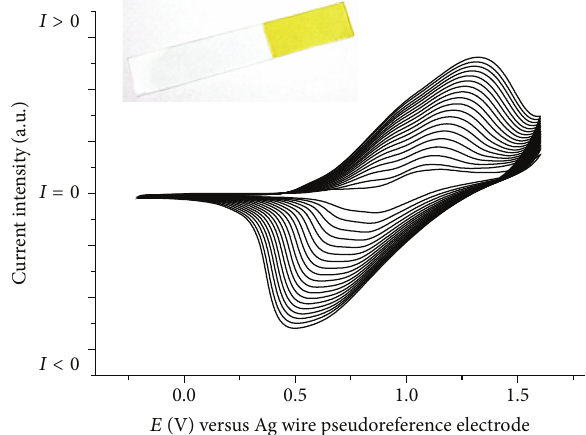
Figure 5: Electropolymerization of IV on ITO substrate (20